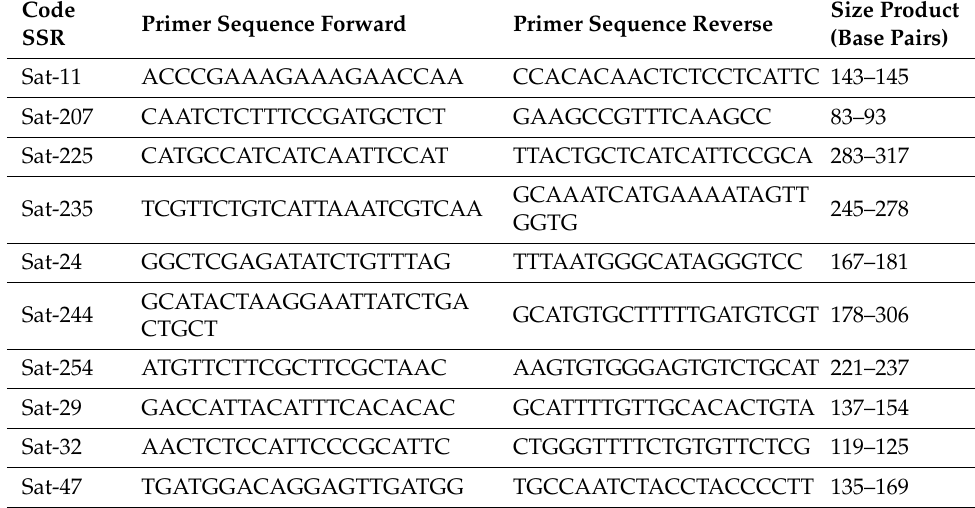
Table 2. List of microsatellite markers with their locus code, primer sequences, and product